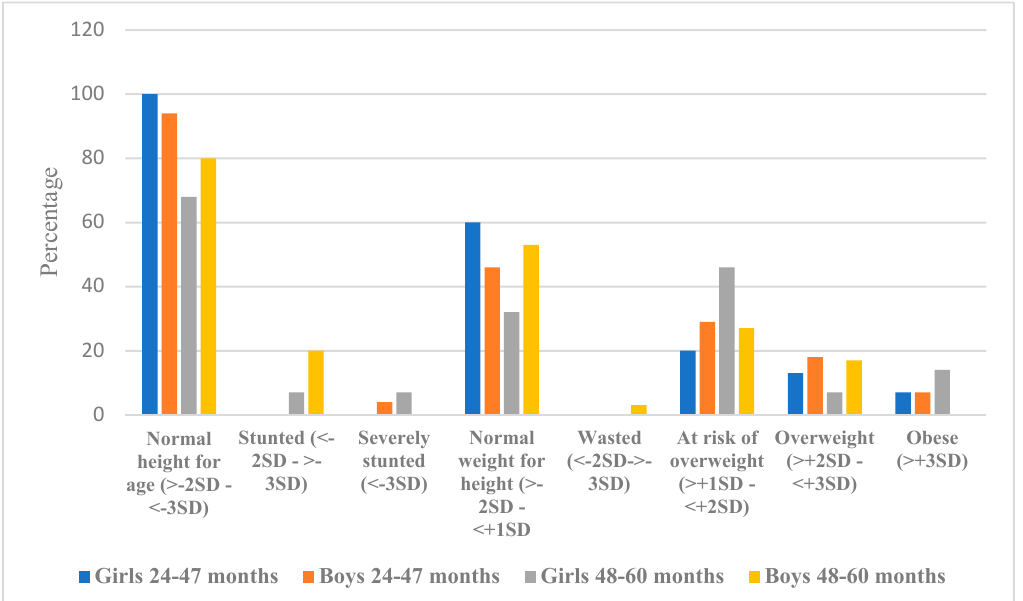
Figure 1. Girls’ and boys’ anthropometric results ( n = 116).